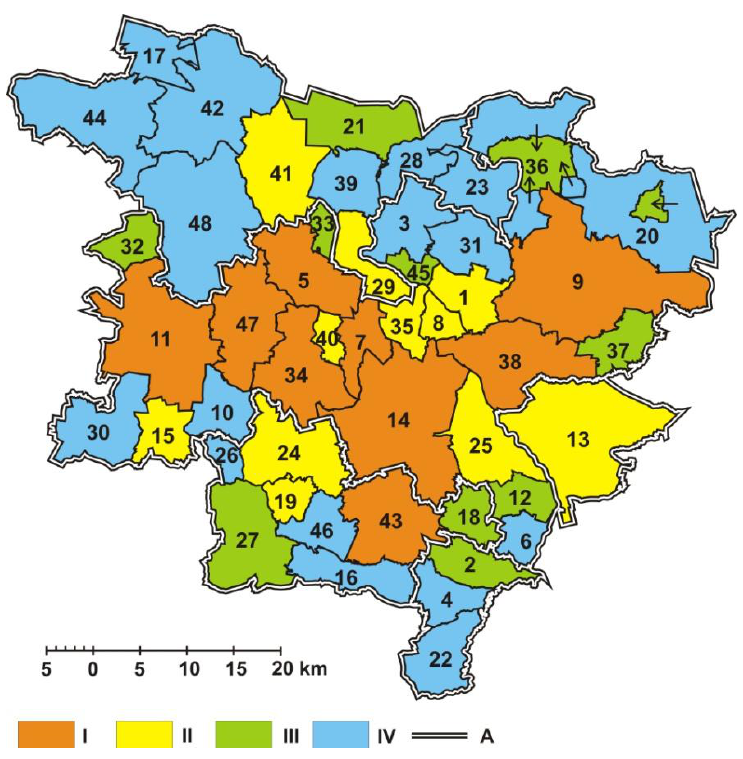
Fig. 1. Research area (own